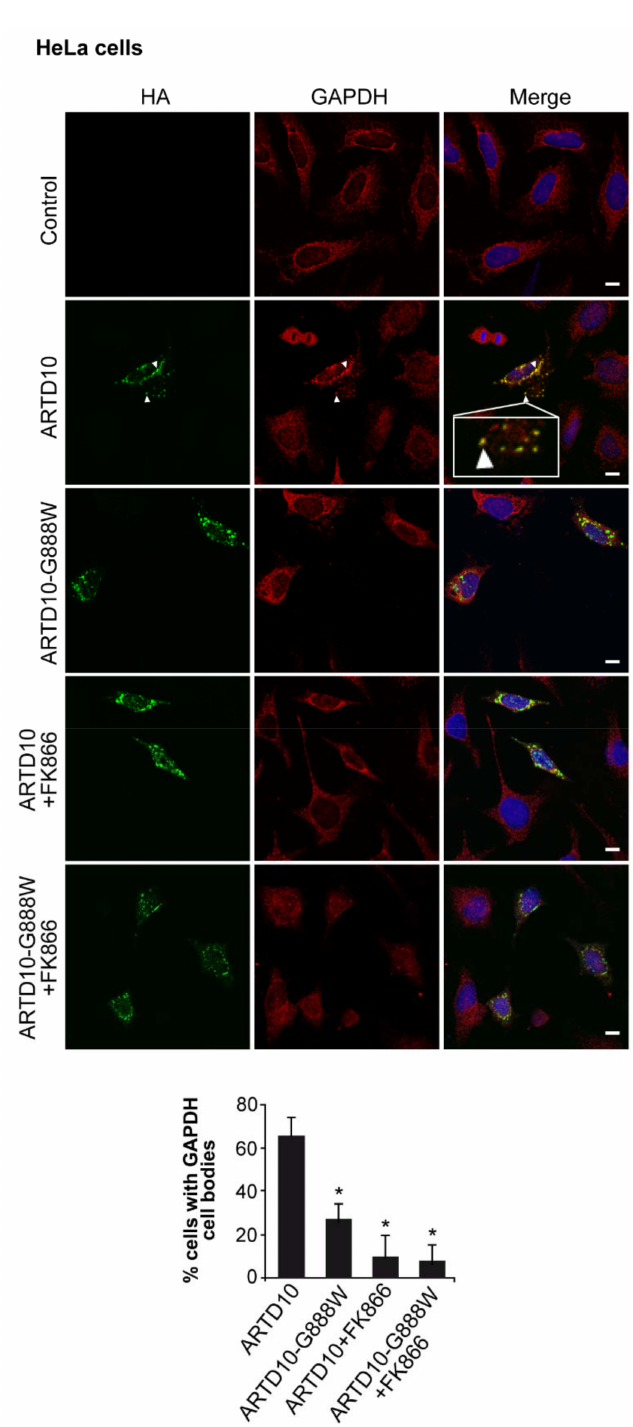
Figure 4. Staining of overexpressed ARTD10/PARP10 and endogenous GAPDH in HeLa cells. Representative immunofluorescence microscopy of HeLa cells that were mock transfected (Control) or were transiently transfected with HA-ARTD10 or HA-ARTD10-G888W, without and with treatment with FK866 (HA-ARTD10 + FK866, HA-ARTD10-G888W + FK866). The cells were stained with anti-HA (HA; green) and anti-GAPDH (GAPDH; red) antibodies, and analysed by immunofluorescence microscopy. The nuclei were stained with DRAQ5. Transfected cells treated with FK866 were incubated for 24 h with 10 nM FK866. Scale bars, 10 µ m. Quantification of % ARTD10 cytoplasmic cell bodies positive for GAPDH is shown, with the data expressed as means ± SD of three independent experiments. *, p < 0.01. The inset shows the localization of GAPDH in cytoplasmic cell